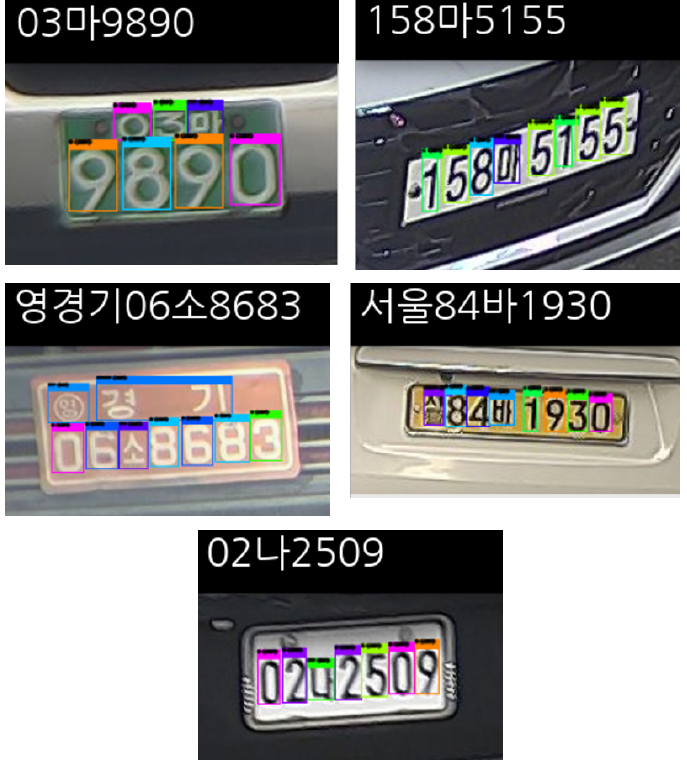
Figure 15. Output examples of the LPC detector in phase 2 using the AI-Hub dataset which reads as